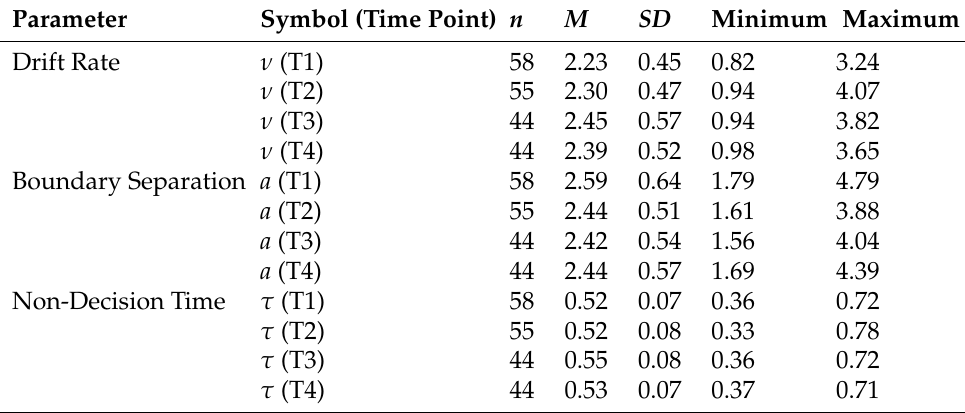
Table A5. Summary statistics of the individual diffusion model parameter estimates for each time point for Group 4.